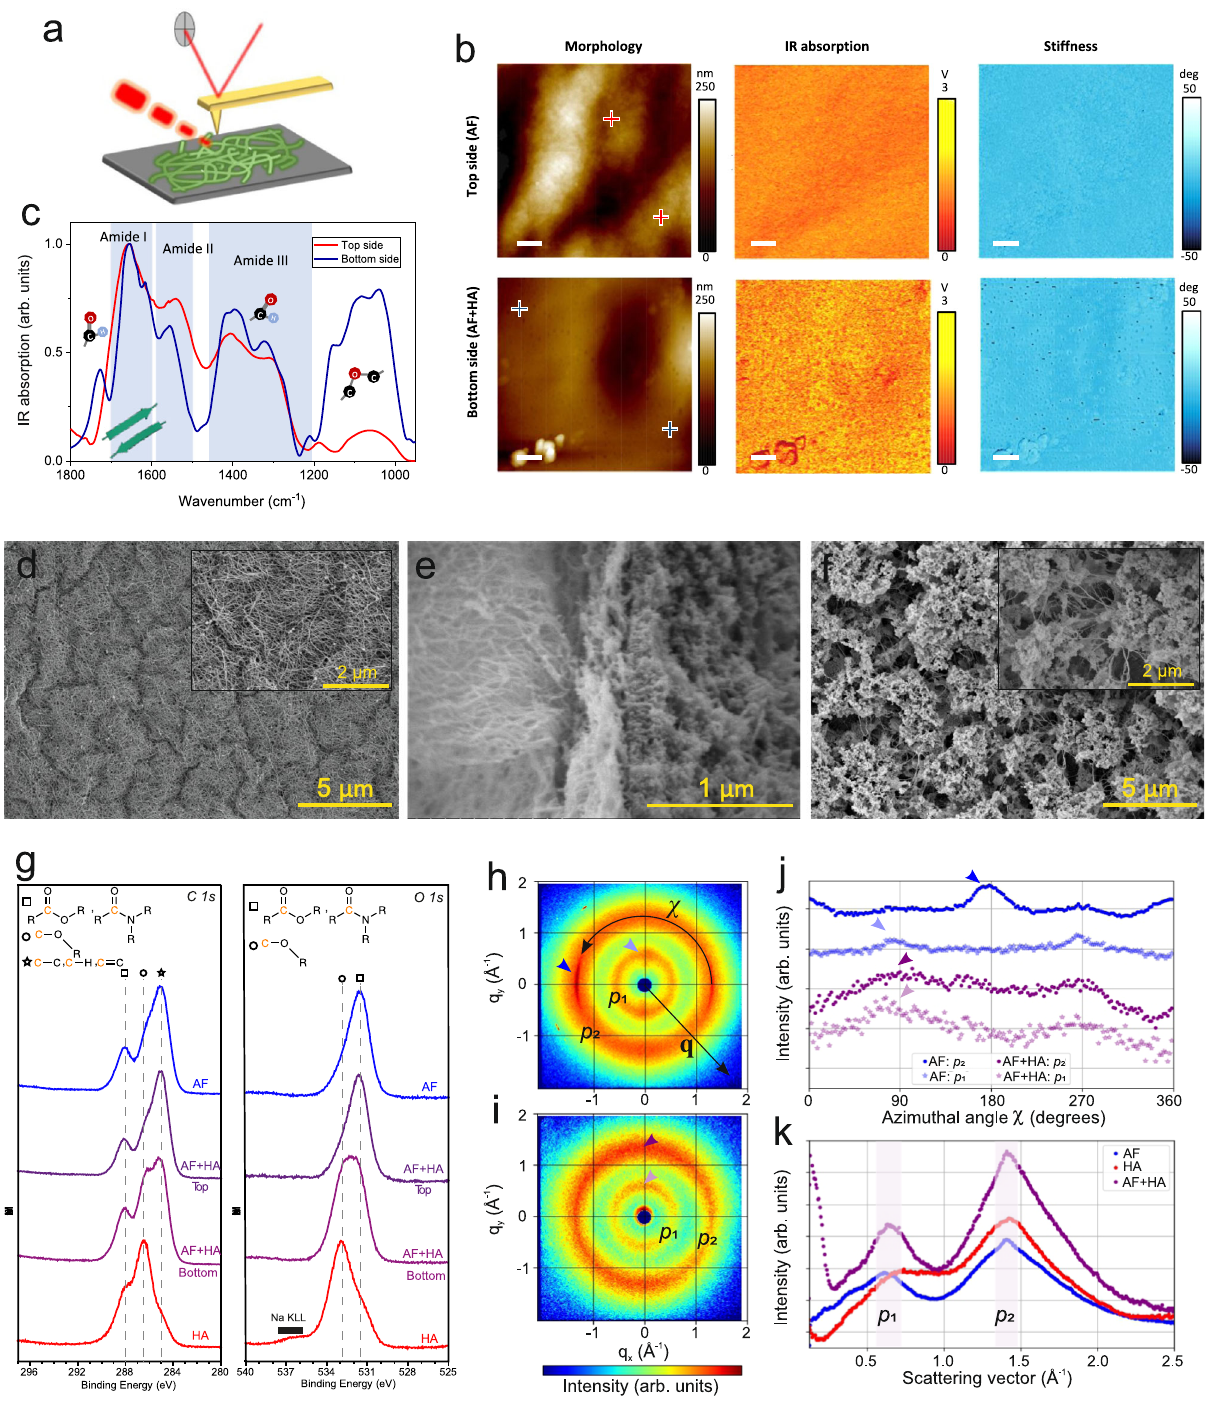
Fig. 3 | Characterization of amyloid fi brils (AF) - hyaluronic acid (HA) coa- cervate fi lms at different sides and interfaces. a The scheme of AFM-IR experi- mental setup while scanning on the fi lm. b Morphological images (left), maps of infrared (IR) absorption in the Amide I at 1654cm − 1 (middle) and stiffness that indicatesthenanomechanicalpropertiesofthetop(upper)andthebottom(lower) side of the fi lm. The crosses refer to the locations for performing IR spectroscopy measurements. The scale bar is 500nm. The AFM-IR experiment was repeated at least three times and representative images were shown. c Nanoscale localized infrared spectrum of the top and bottom side of the fi lm collected at the crossed